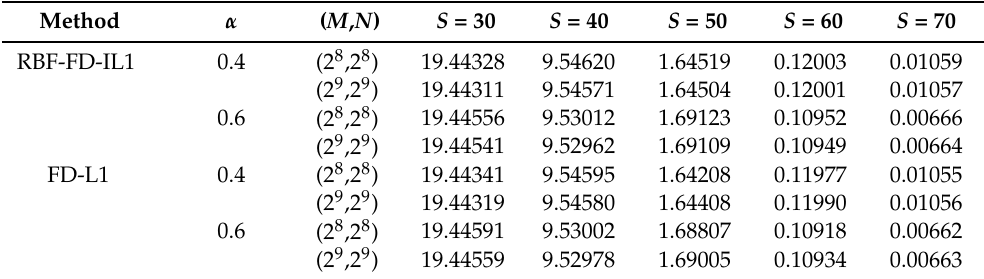
Figure 1. Numerical solutions of European put options with M = N = 200 for α = 0.4 and α = 0.6. Table 1. Values of European put options using the RBF-FD-IL1 and FD-L1 methods, where M and N are the number of points in S and t , respectively.